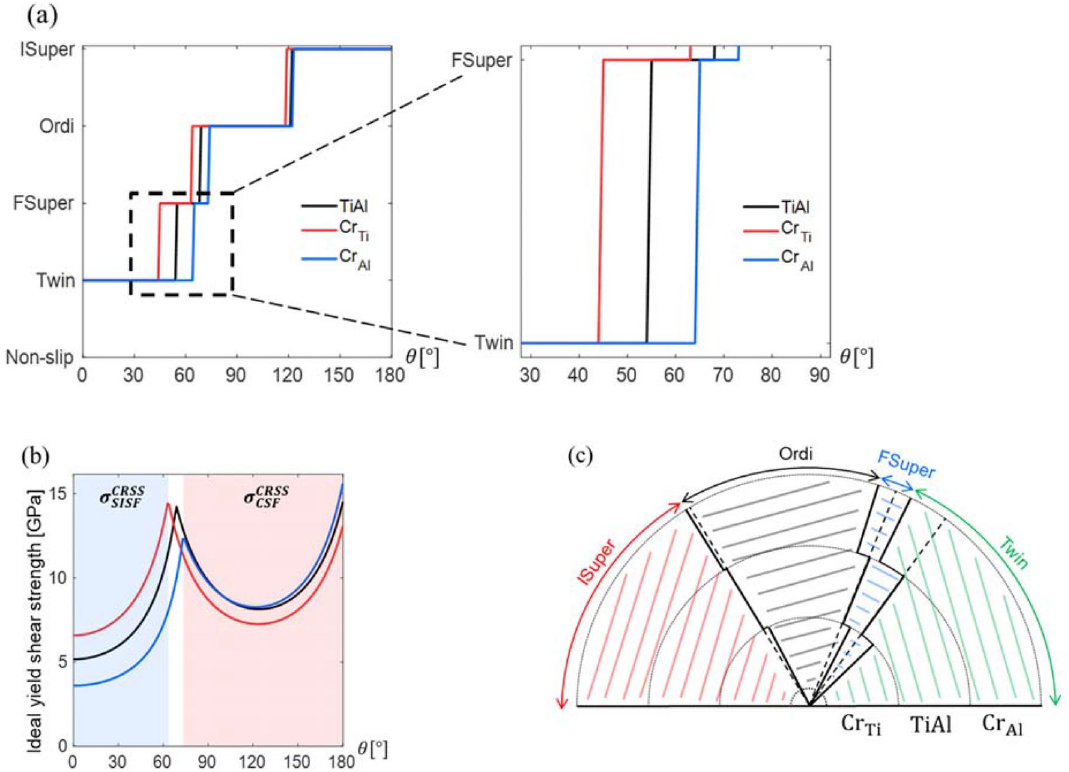
Figure 9. (a) Predicted deformation mechanism. (b) Ideal yield shear strength (the blue and red shaded regions represent SISF and CSF, respectively). (c) Predicted deformation mechanism